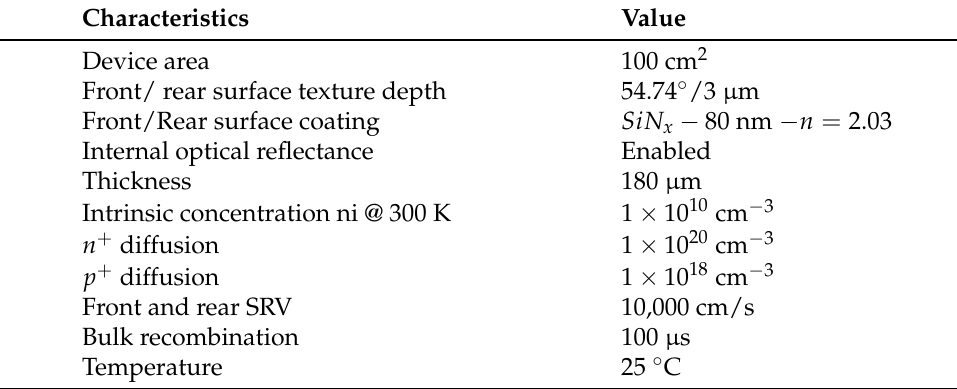
Table 2. Unique characteristics of each appliance used in the